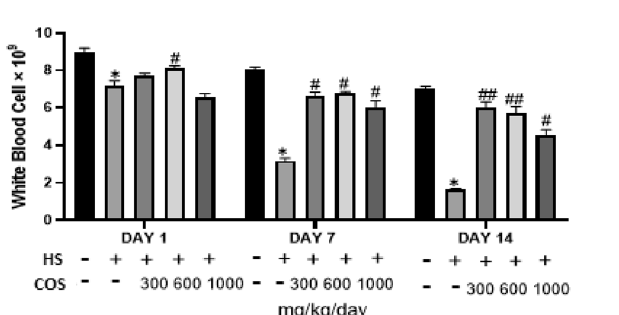
Figure 3. Chitosan attenuates heat stress-induced colitis mice (HE, 100 ×). ( A ) control group ( B ) Heat Stress ( C ) COS LD + HS ( D ) COS MD + HS ( E ) COS HD + HS, 1: 1st day, 2: 7th day, 3: 14th day. Data are expressed as mean ± standard error. *Indicates p < 0.05 compared with the blank control group, # Indicates p < 0.05 compared with the HS control group.